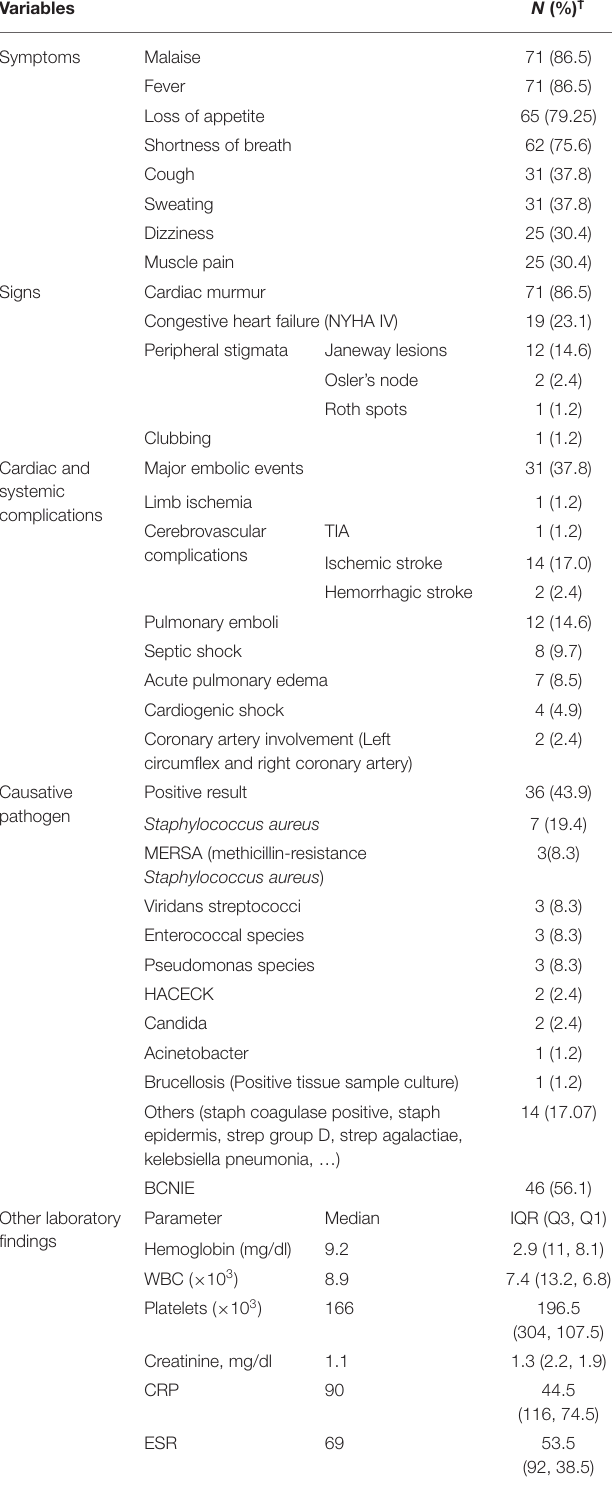
TABLE 2 | Clinical characteristics, laboratory features, with systemic and cardiac complications on admission. Variables